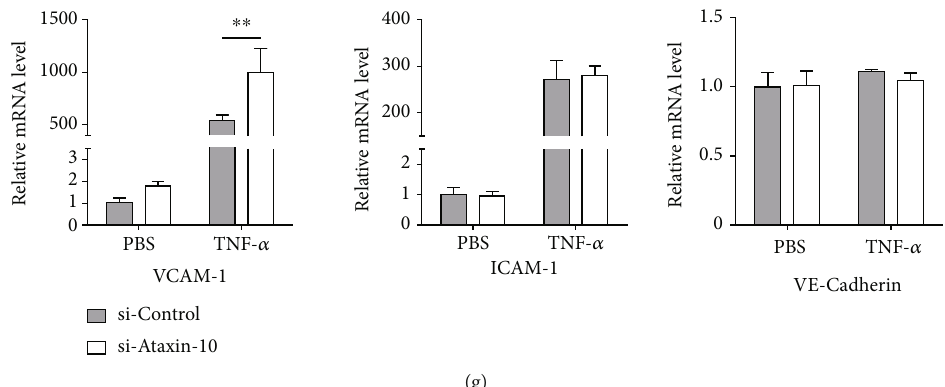
Figure 3: E ff ects of Ataxin-10 on adhesion molecule expressions in TNF- α -activated HUVECs. (a, d) Representative images of Western blotting for the detection of indicated protein expression. (a) HUVECs were transfected with either EV or HA-Ataxin-10 for 48h, followed by stimulation with TNF- α (10 ng/mL) for the indicated times. Total cell lysates were used for immunoblotting analysis with appropriate antibodies (right panel). (b) Densitometry analysis of 3 independent experiments is shown as the relative ratio of each protein after TNF- α treatment (8 h) and normalized to β -actin. (c) HUVECs were transiently transfected with HA-Ataxin-10 or empty vector (EV) for 48 h. Then, cells were incubated with TNF- α (10 ng/mL) or PBS (as controls) for another 4h. qPCR assays were performed to determine the mRNA levels of Ataxin-10 and adhesive molecules. ∗∗∗ p < 0 : 001 vs. EV control group. (d) Ataxin-10 siRNAs or control siRNAs were transfected transiently into HUVECs. 48h later, transfected cells were stimulated with TNF- α (10 ng/mL) for 0, 4, 8, and 24 h. Protein levels of VCAM-1, ICAM-1, and VE-cadherin were determined. Relative fold changes of Ataxin-10 (e) or adhesion proteins (f) after TNF- α stimulation (8 h) were con fi rmed by densitometry and normalized to β -actin. ∗ p < 0 : 05 and ∗∗∗ p < 0 : 001 vs. si-control group. (g) Ataxin-10 siRNAs/control siRNAs were transfected into endothelial cells. 24 h later, cells were incubated with TNF- α (10 ng/mL) or PBS (as controls) for another 4h. qPCR assays were performed to determine the mRNA levels of adhesive molecules. ∗∗ p < 0 : 001 vs. si-control